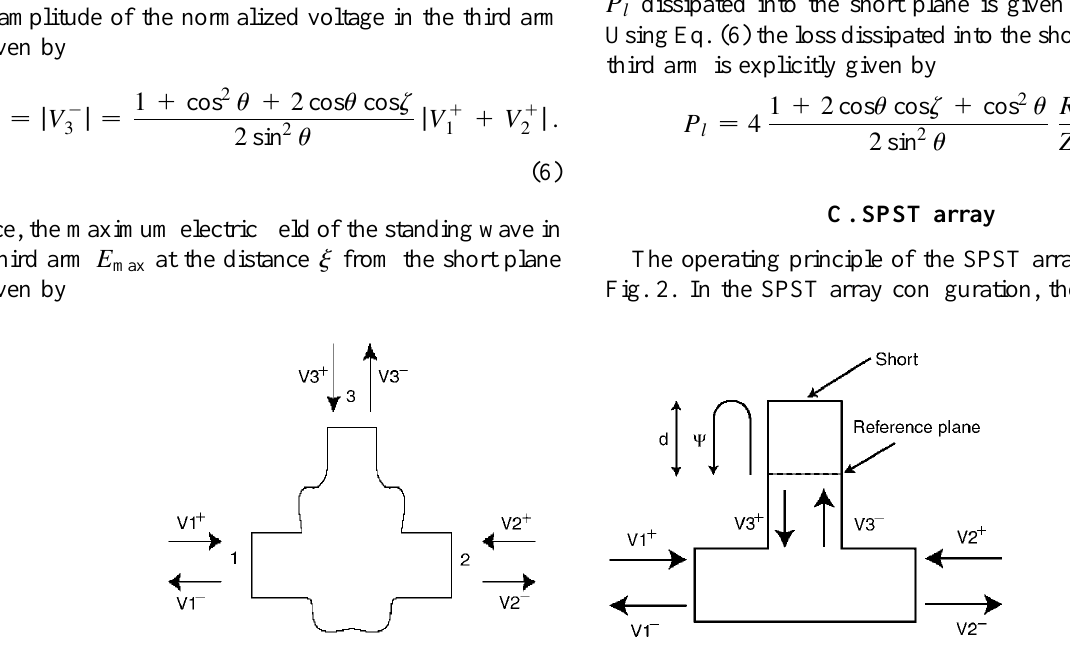
FIG. 5. (a) Symmetrical tee-junction element. (b) The three-port network as a control